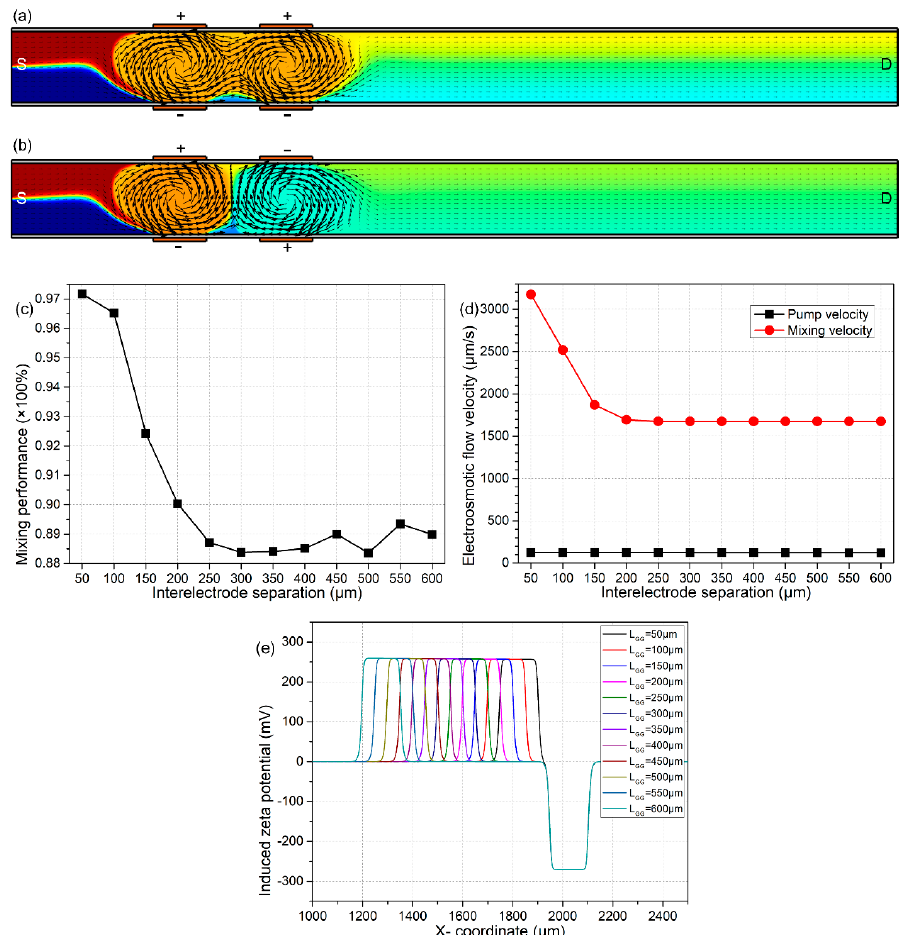
Figure 5. In an improved device configuration with two neighboring sets of gate electrode pairs, a numerical analysis of the effect of electrode separation L GG between adjacent G terminals for given values of Vs = 70 V, V G1 = − V G2 = 2000 V and L G = 150 μm. ( a , b ) An arrow and surface plot of DCEO fluid motion and resulting analyte concentration distribution (unit: mol/m 3 ) for different combinations of external gate polarities; ( a ) for a neighboring GE pair of identical voltage polarity, two sequential ICEO vortexes of the same rotating directions are produced in the vicinity of the four G terminals, so that a non-ideal mixing efficiency of γ = 83.66% is obtained at the channel exit; and ( b ) for two external sets of gate electrodes of an upside-down polarity combination, an alternation in the rotating direction of the forward sample motion trajectory within the mixing region enables a much higher mixing performance of γ = 92.43% at the outlet port, which is named ‘double-inverted B-DCFFET’. ( c – e ) For double-inverted B-DCFFET, (c) the mixing index as a function of interelectrode gap width L GG , (d) L GG -dependent electroosmotic pump and mixing flow velocity and (e) distribution of non-uniform induced zeta potential along the planar channel sidewall adjacent to the left two gate electrodes of opposite voltage polarities for different interelectrode separations L GG , in which the left-side positive and right-side negative zeta potential represent the negative and positive induced counterionic charges next to the side-by-side positively- and negatively-polarized G terminals, respectively.